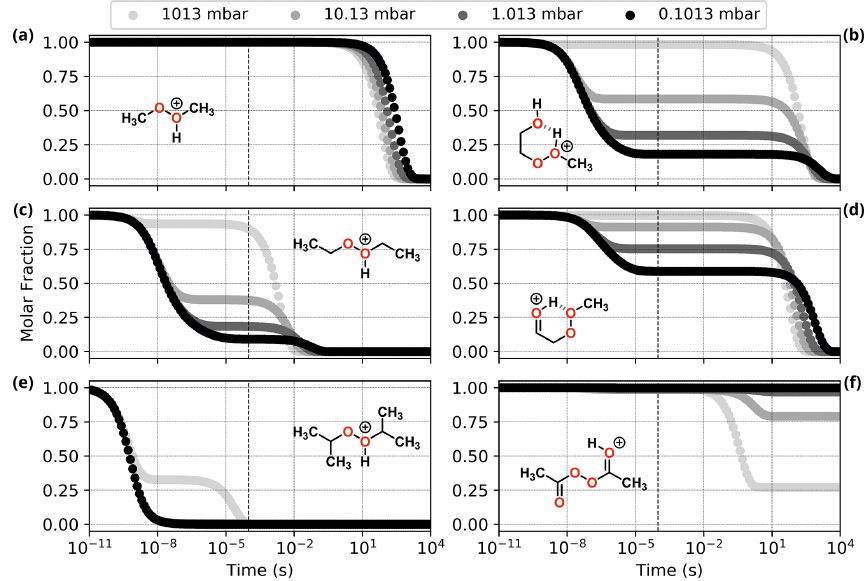
Figure 6. Reaction dynamics simulation results for model ROOR systems. Graphs represent the time evolution profile of initial protonated reactants due to fragmentation, at 298.15K. (a, c, e) From top to bottom: MeOOHMe + , EtOOHEt + , and iPrOOHiPr + ; (b, d, f) from top to bottom: HOEtOOHMe + , HO = EtOOMe + , and AcOOAcH + (Z) . Dashed line indicates 100µs from the start of the